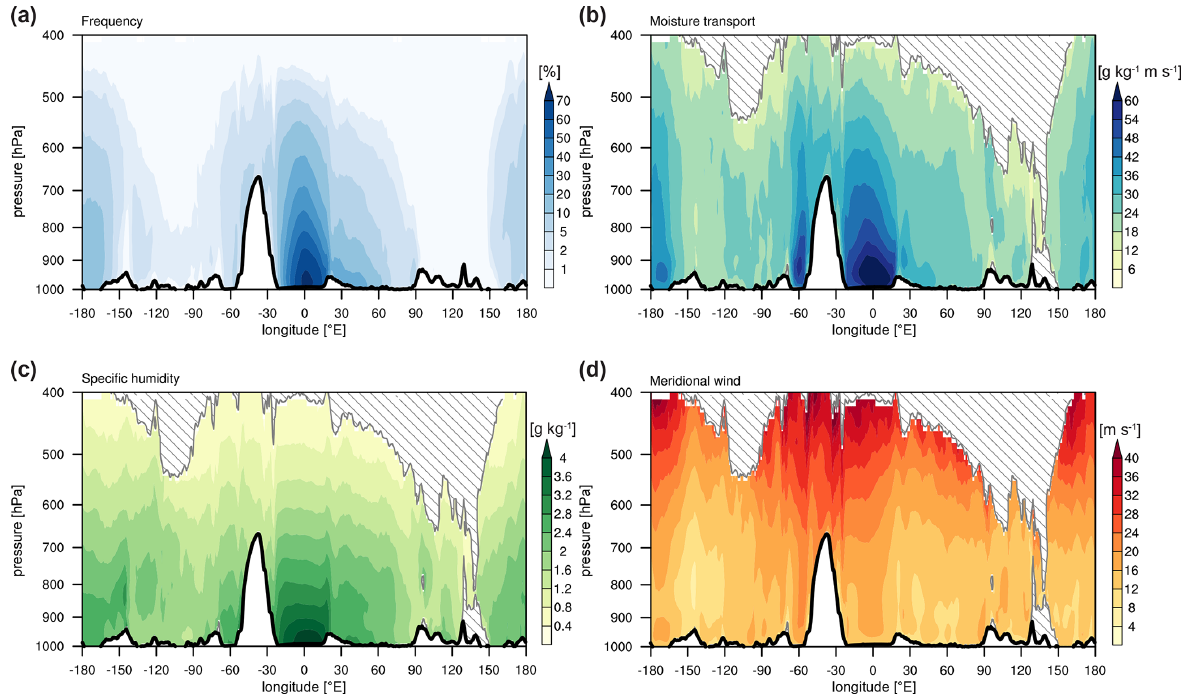
Figure 2. Vertical cross sections at 70 ◦ N showing (a) relative frequency of trajectory starting points contributing to moist-air intrusions and mean (b) meridional moisture transport ( v · q ), (c) specific humidity ( q ), and (d) meridional wind ( v ) during moist-air intrusions as a function of longitude and pressure. In panels (b) – (d) regions with a trajectory frequency of less than 0.1% are masked out by gray